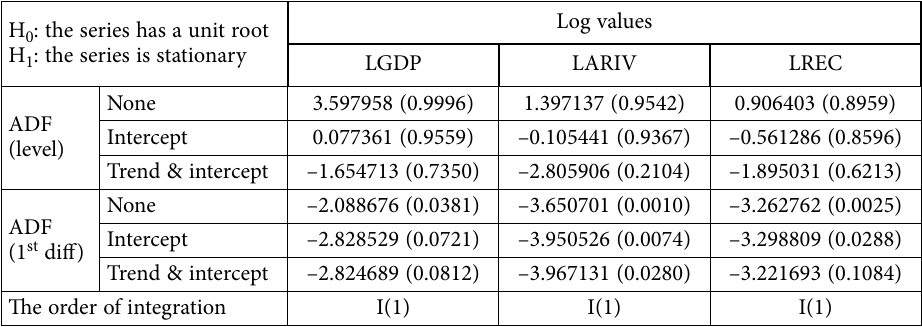
Table 3. Unit root test results (ADF test) (source: own calculations using Eviews 9) H 0 : the series has a unit root H